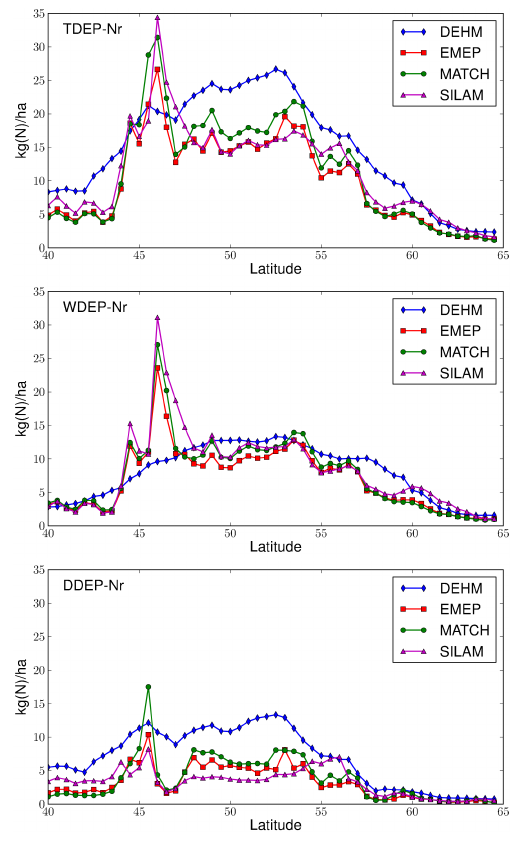
Figure 8. Calculated base-case deposition along the 10 ◦ east tran- sect (cf. Fig. 1), for total Nr deposition (top), wet deposition (mid- dle), dry deposition